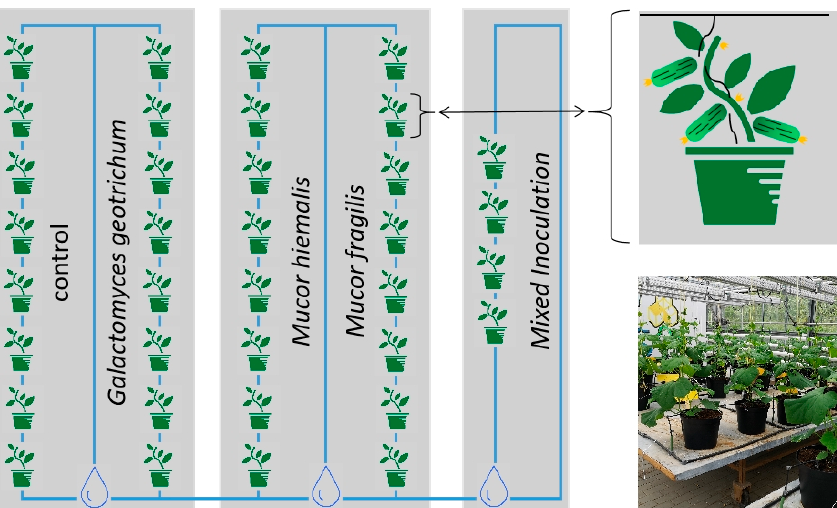
Figure 1. Cultivation design of Cucumis sativus plants grown in the greenhouse. Fully opened blossoms of eight gherkin plants were inoculated with one of the three fungi Mucor hiemalis , Mucor fragilis, or Galactomyces geotrichum by spraying spore suspension obtained from nutrient plates. Blossoms of four plants were inoculated with a mixed spore suspension of all three fungi. Eight plants served as untreated control. Plants with the same treatment were grown side by side and spaced apart from plants with different treatments and control.